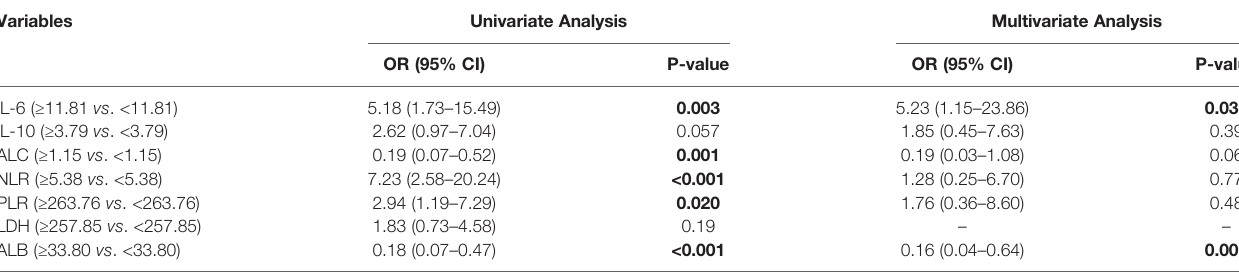
TABLE 3 | Univariate and multivariate logistic regression analysis for the risk factors of grades 3 – 4 CIP in the CIP group. Variables Univariate Analysis Multivariate Analysis OR (95% CI) P-value OR (95% CI)